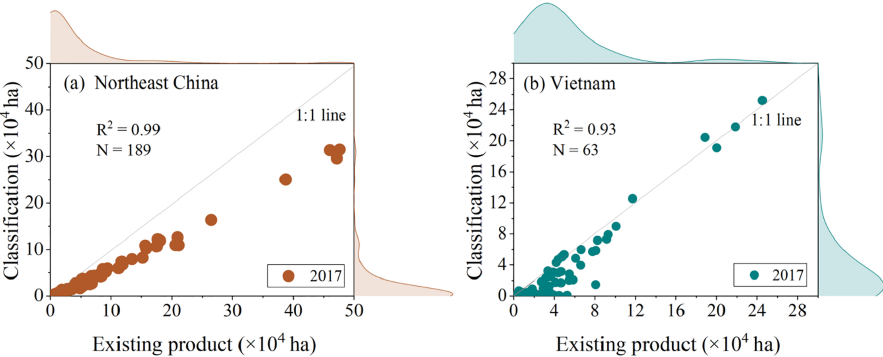
Figure 5. Comparison of the annual paddy rice area between our classification and existing datasets at the subnational level in Northeast China (a) and Vietnam (b) . The marginal kernel density plot above or to the right of each scatterplot shows the distribution of the data in one